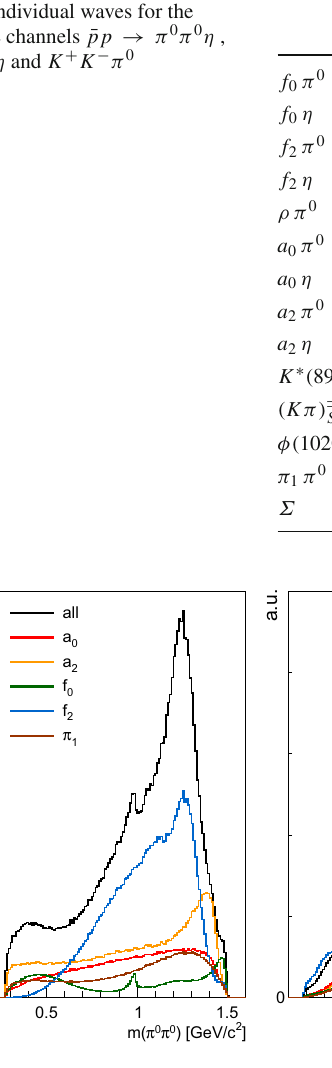
Fig. 14 Efficiency corrected invariant π 0 π 0 -(left) and π 0 η -mass (right) for the reaction ¯ pp → π 0 π 0 η . The overall result is marked in black, while the individual contributions are visualized by different colors